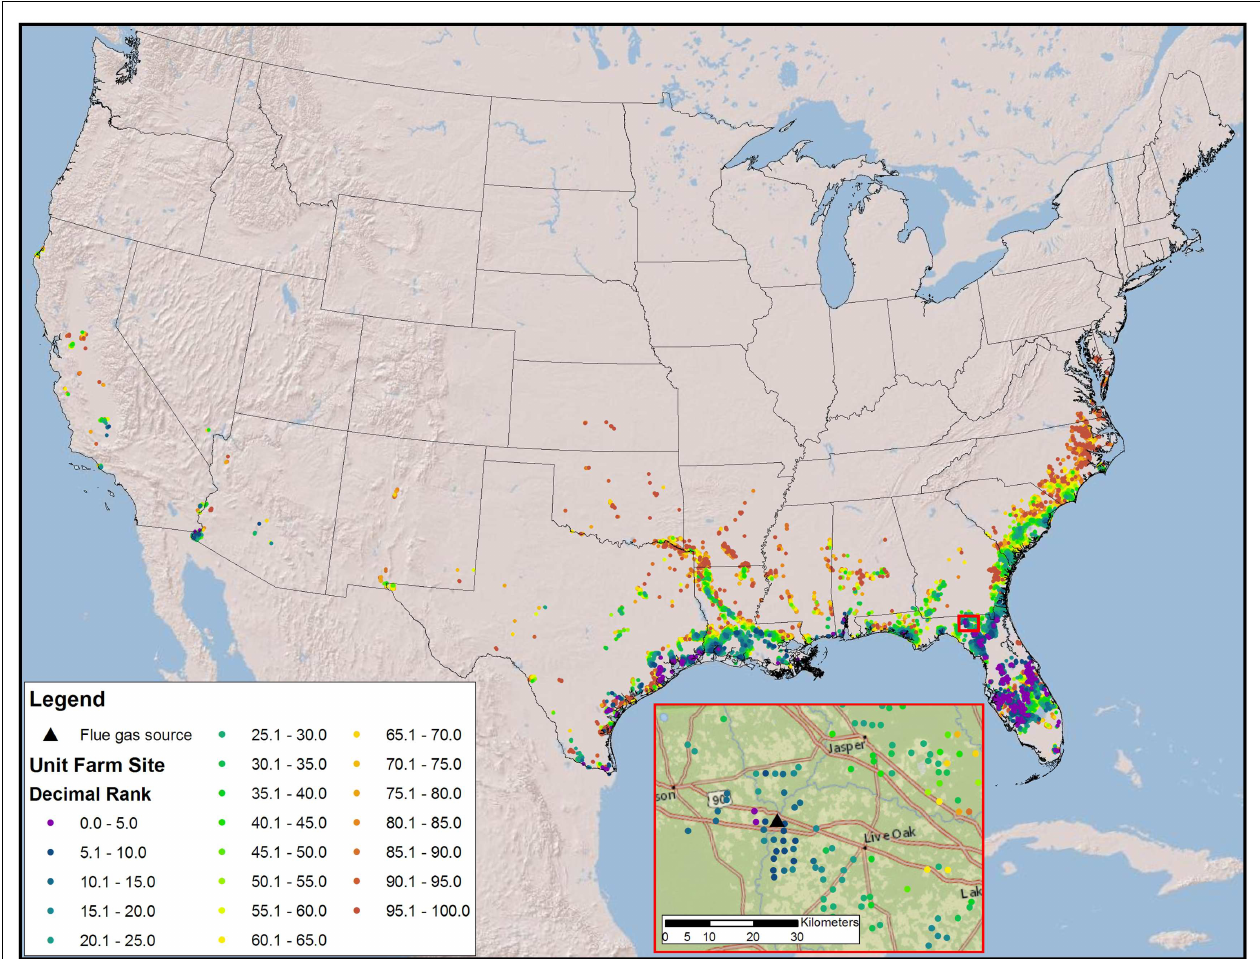
FIGURE 4 | Map of the CONUS showing the number and locations of sites require to produce 36 BGY constrained by freshwater and flue gas resources and prioritized by fuel value minus resource costs .The inset map illustrates the complexity of ranks for a very small geographic